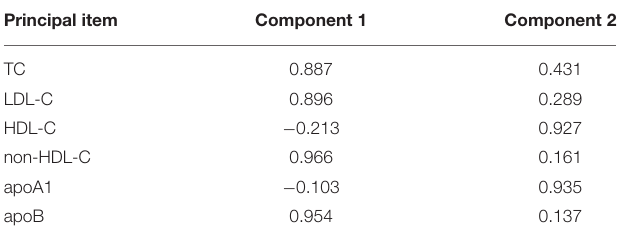
TABLE 3 | The factor matrix for the component analysis.